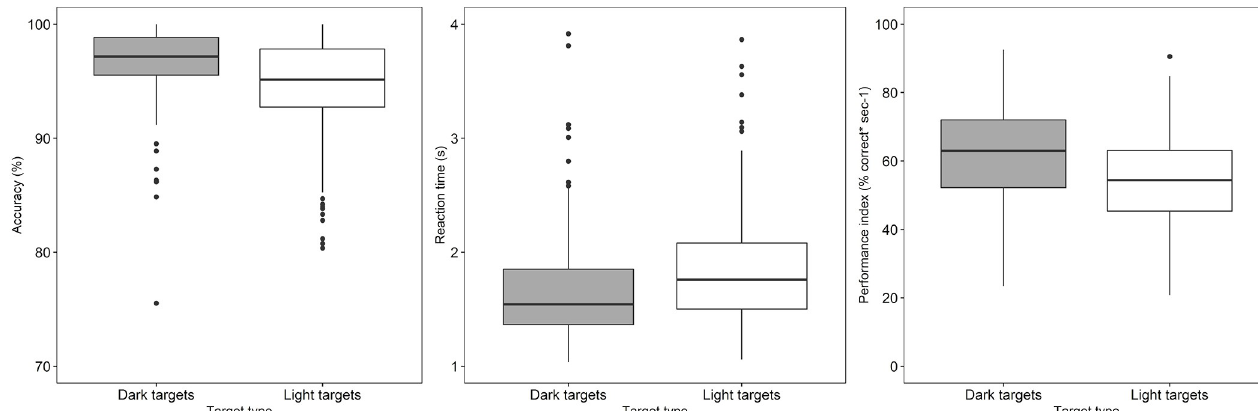
Fig 3. Box plots showing the accuracy (left panel), reaction time (middle panel) and performance index (right most panel) of all the subjects for dark and light targets respectively. The central solid horizontal line in each box represents the median and the solid black circles represent the outliers.